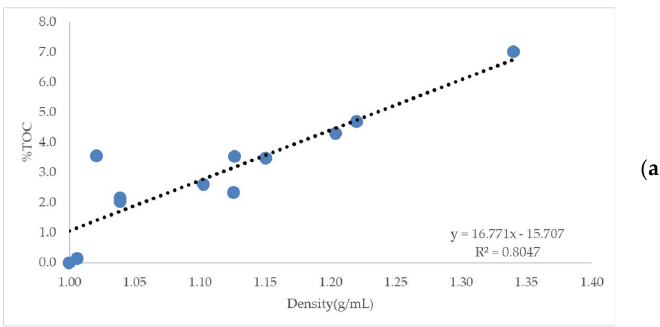
Table 2. Carbon content properties of original and concentrated leachates (October 2017 and June